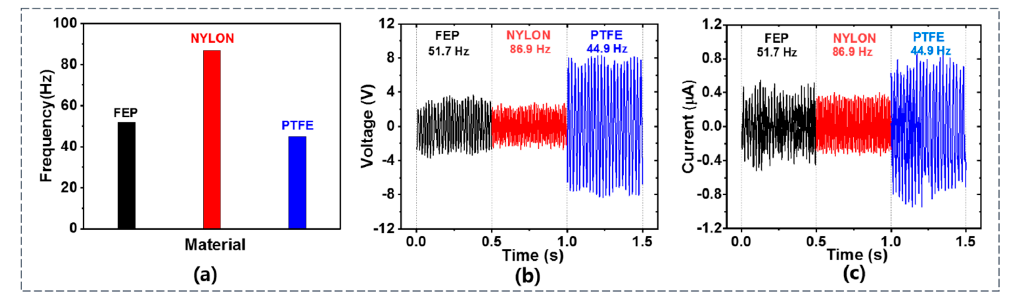
Figure 3. ( a ) Frequency, ( b ) voltage, ( c ) current of TENG flowmeter with various membrane materials.